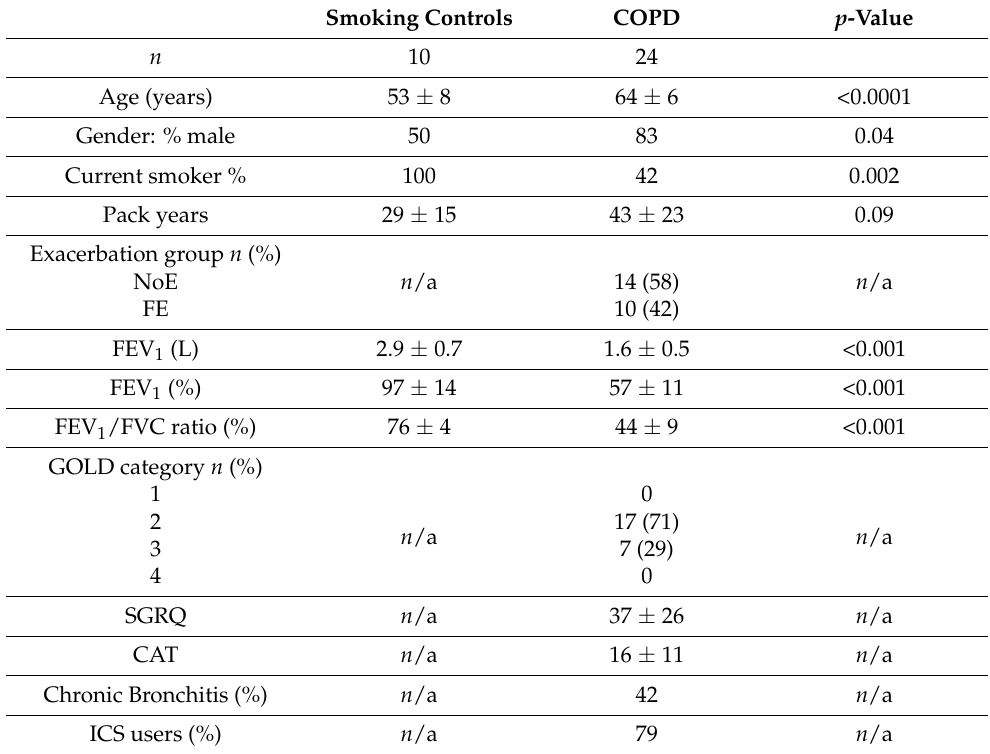
Table 1. Clinical characteristics of the study population. Smoking Controls COPD p